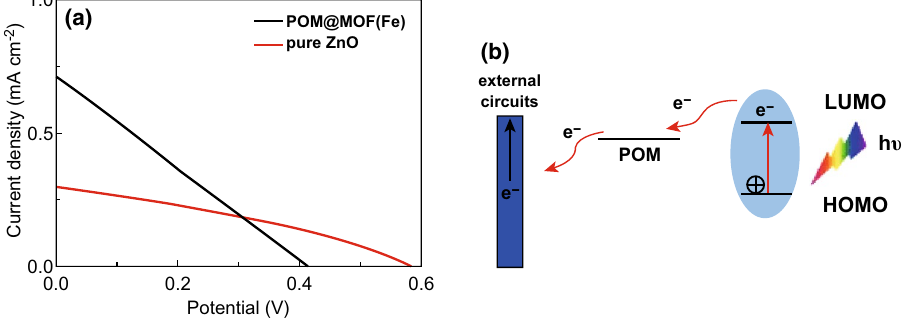
Fig. 5 a J – V curve of cell with pure ZnO and POM@MOF(Fe)-modified ZnO photoanode. b Mechanism of charge transfer of POM@ MOF(Fe). Reprinted with permission from Ref. [21]. Copyright 2017, Springer